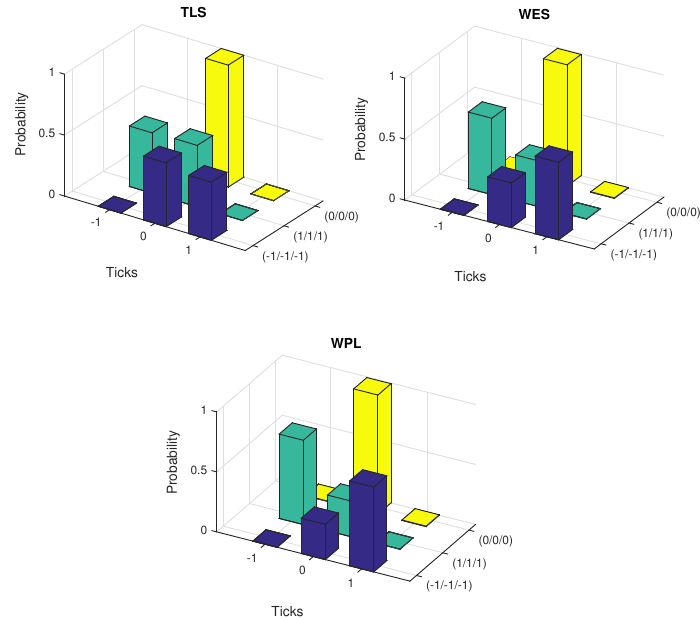
Figure 6. Distribution of estimated probabilities of direction of price change conditioned on constant, increasing and decreasing past price changes.